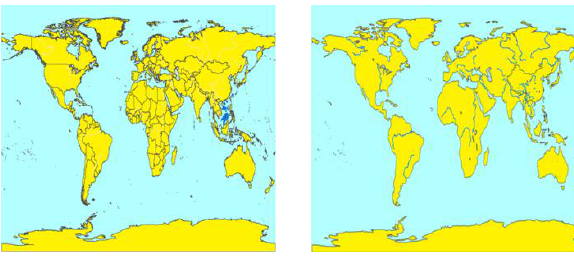
Figure 8.Overall Comparison Chart of Plate